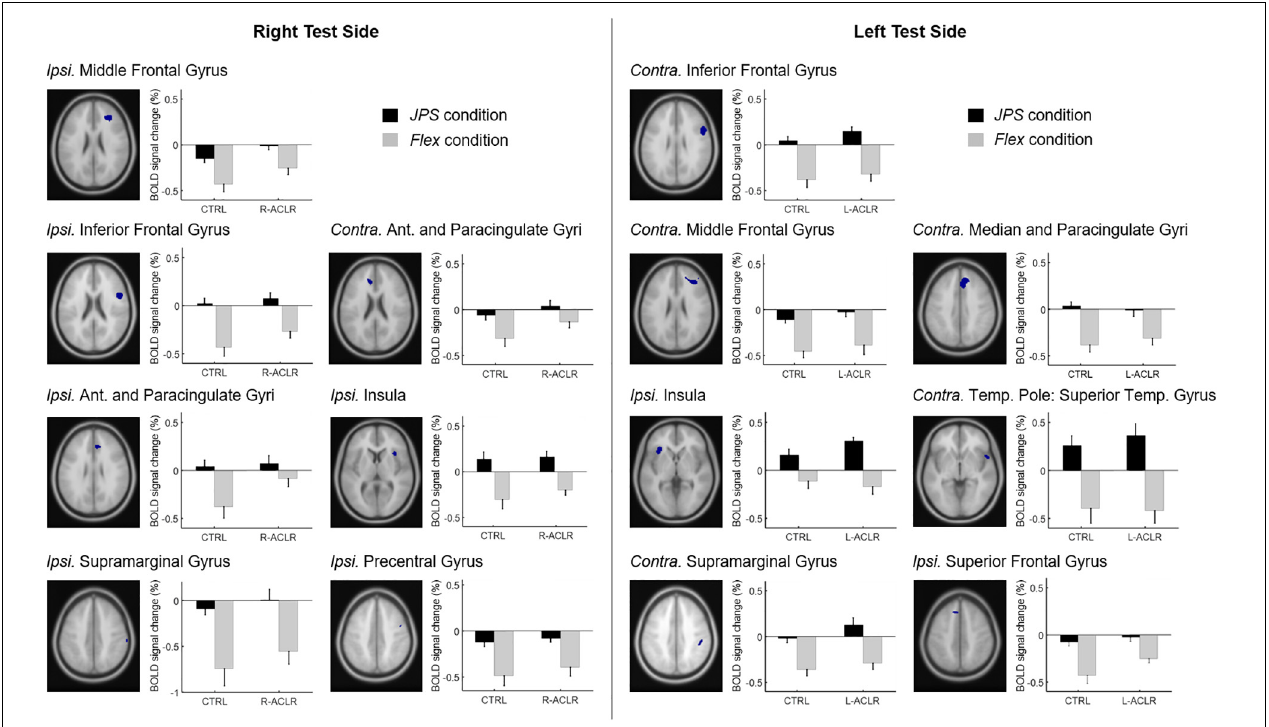
FIGURE 4 | BOLD signal change (%) during angle reproduction of the JPS test for the brain regions with a significant main effect from condition [( JPS > Rest ) > ( Flex > Rest )]. Ant., Anterior; Contra. , contralateral; CTRL, asymptomatic control group; Flex , flex condition; Ipsi. , ipsilateral; JPS, joint position sense condition; L-ACLR, left side anterior cruciate ligament-reconstructed group; R-ACL, right-side anterior cruciate ligament-reconstructed group; Temp.,